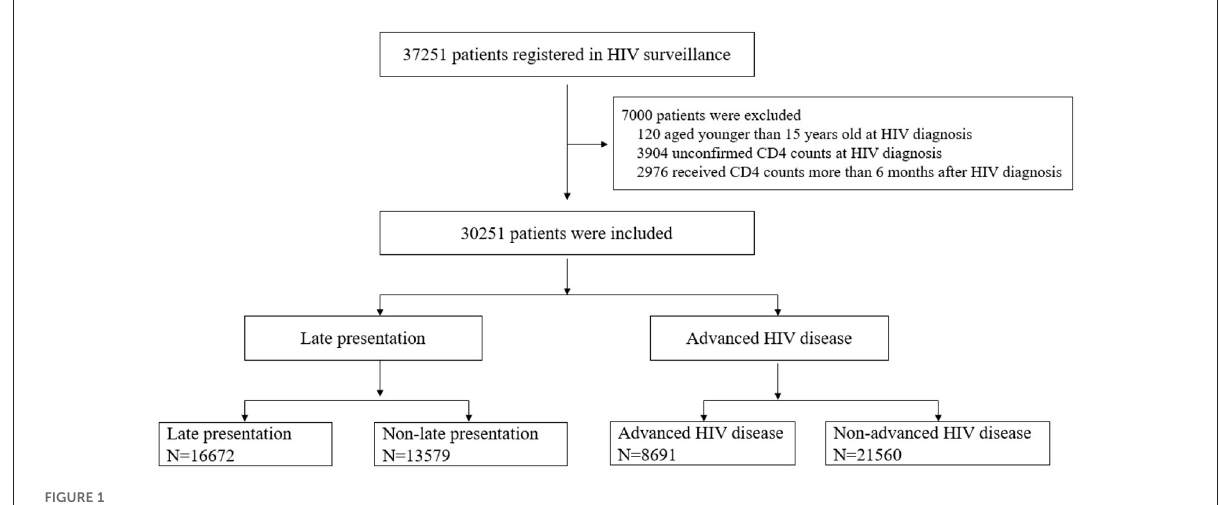
FIGURE1 Chart of the inclusion and exclusion criteria in this